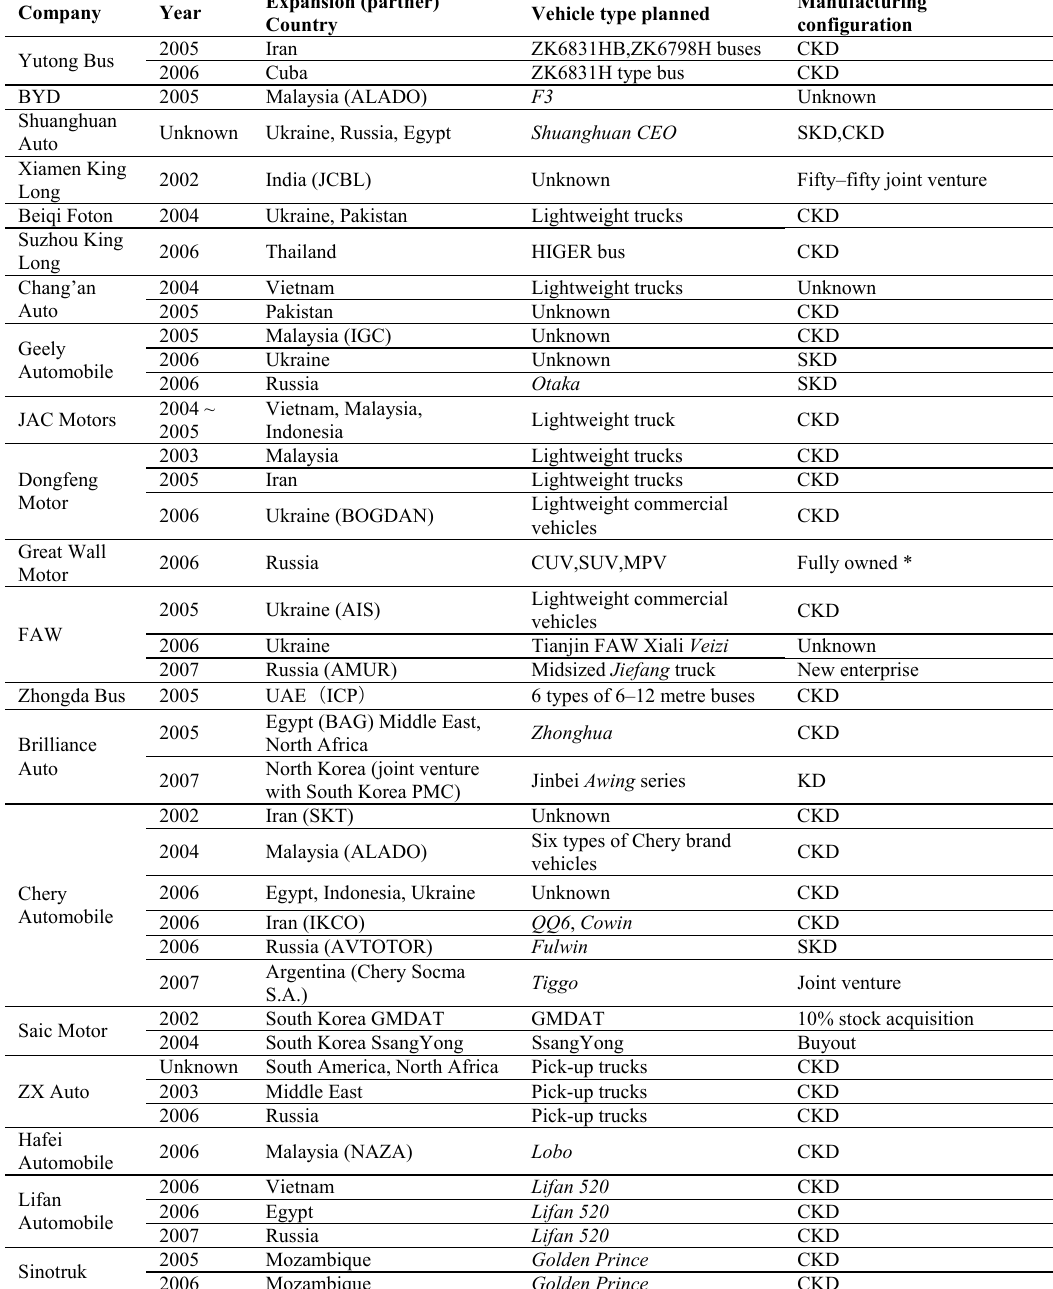
Table 1. The overseas manufacturing status of independent manufacturers (March 2007)